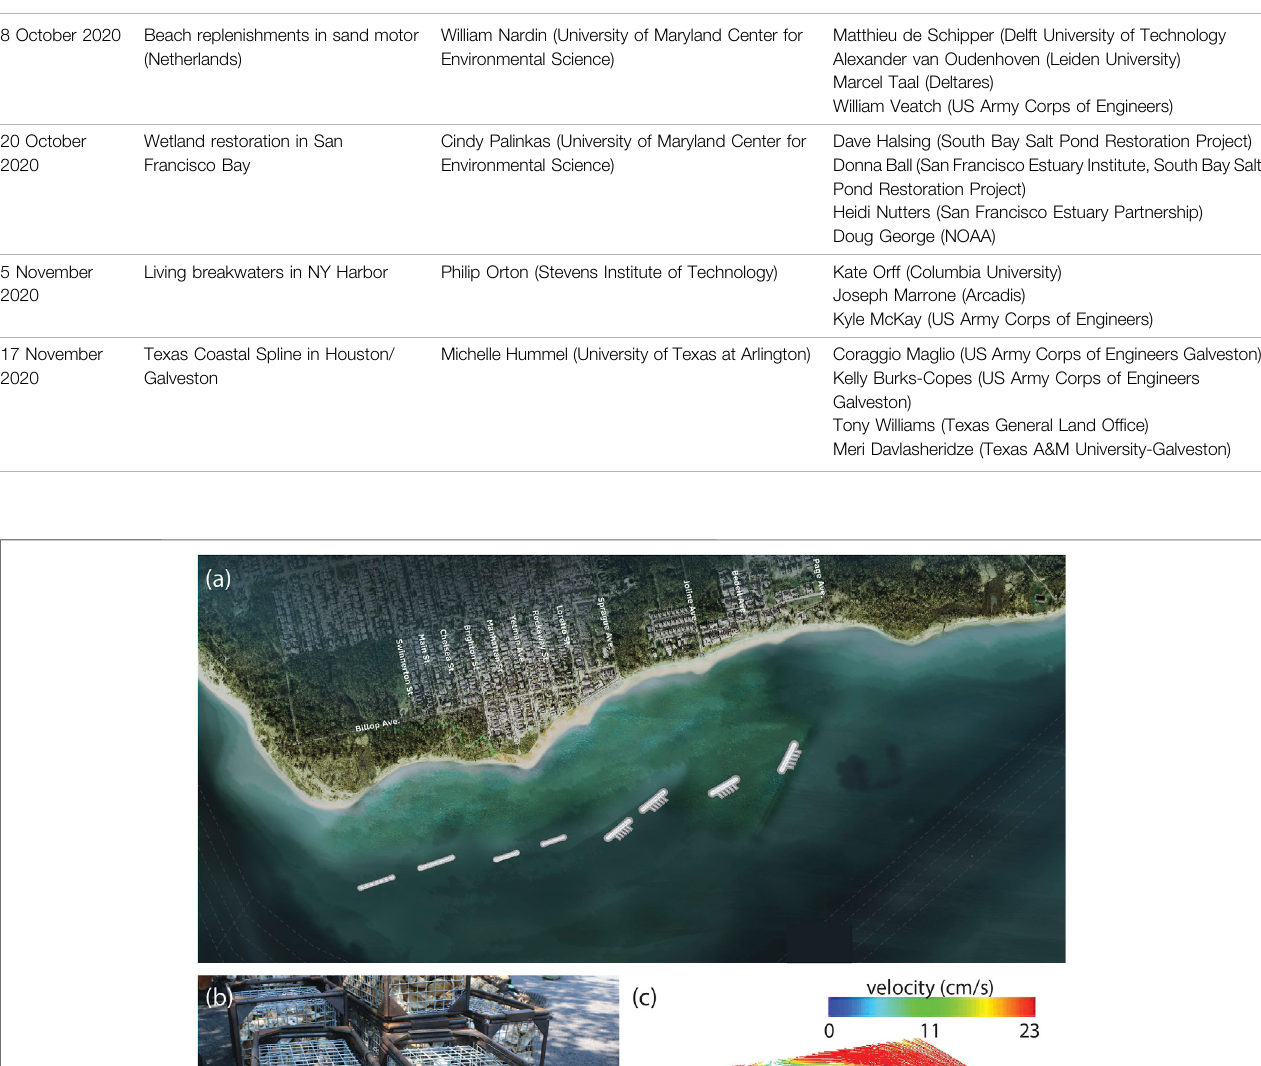
Frontiers in Built Environment |